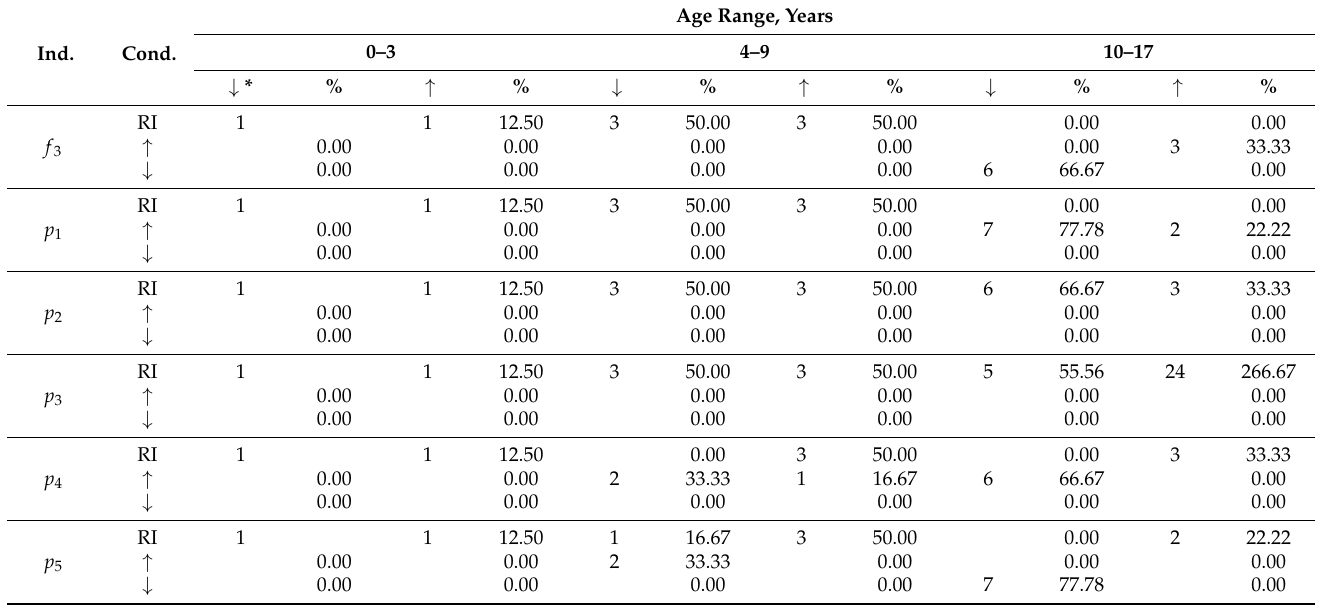
* The arrows in the table header show the deviation in the immunoglobulins to the smaller ↓ or more ↑ region relative to the reference interval. Table 6. Immunogram analysis for the state of the immune system k 4